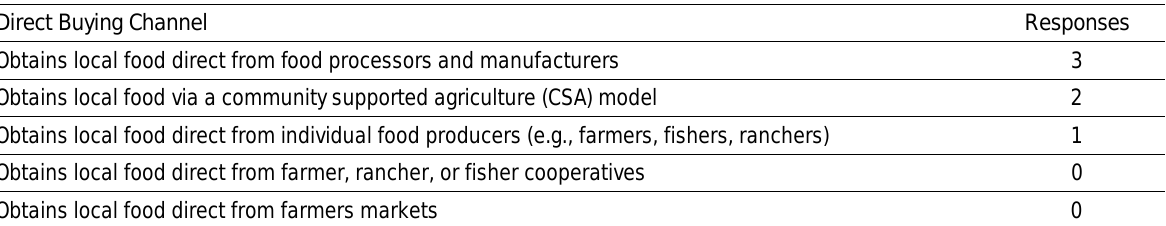
Table 4. Southern Arizona School Food Authorities’ (SFAs’) Local Food Direct-Buying